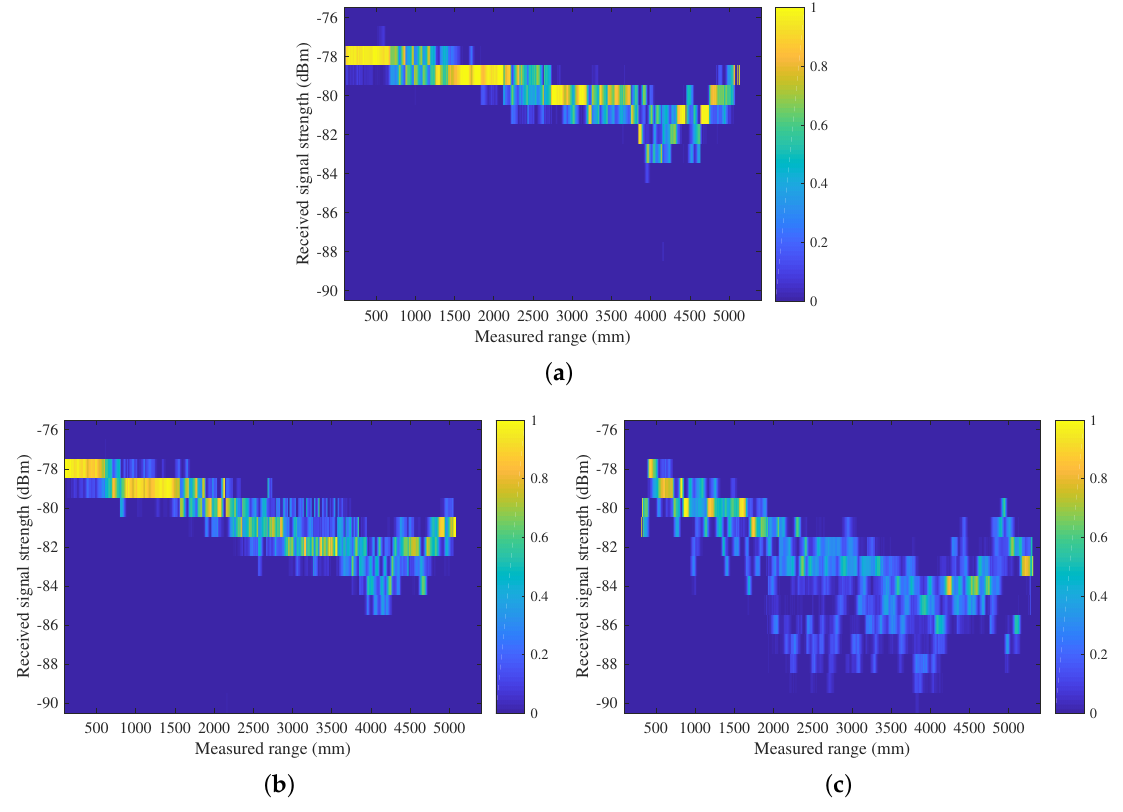
Figure 2. The received signal strength (RSS) sensor model built for ( a ) LOS ; ( b ) NLOS W ; and ( c ) NLOS M UWB signal propagation cases based on 132,651, 196,063, and 200,659 measurement samples,